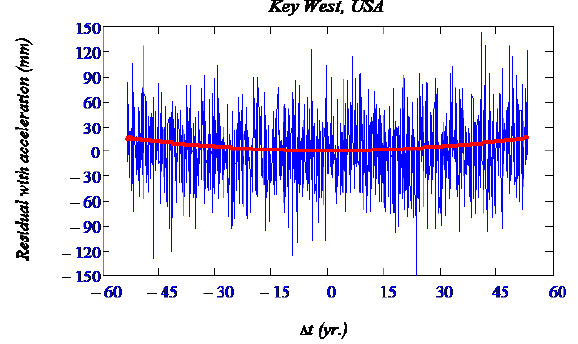
Fig. 3. The unmodeled uniform acceleration, shown in red, is em- bedded in the residuals, which is difficult to discern snd verify if it is uniform.